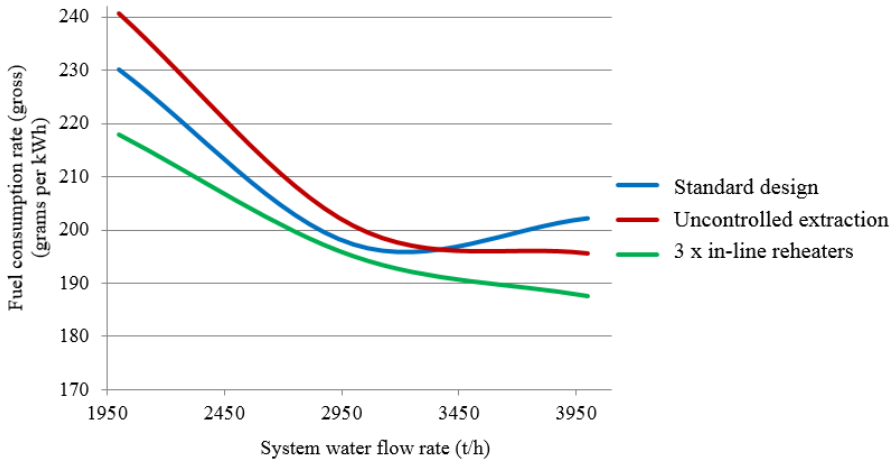
Figure 11. Plots of specific fuel-equivalent flow rates as a function of the system water flow rate for generating unit thermal systems at an outdoor air temperature of −15 °C.